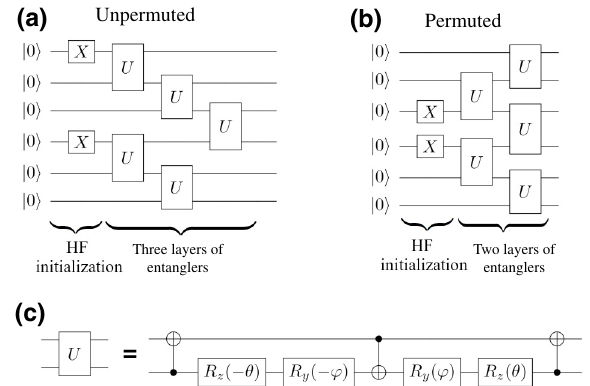
FIG. 6. Example of particle-preserving hardware-efficient simulation. (a) The 3-depth ansatz ansatz that are used in H + 3 used with the unpermuted Hamiltonian. (b) The 2-depth ansatz used with the permuted Hamiltonian. (C) An electron-preserving entangler.